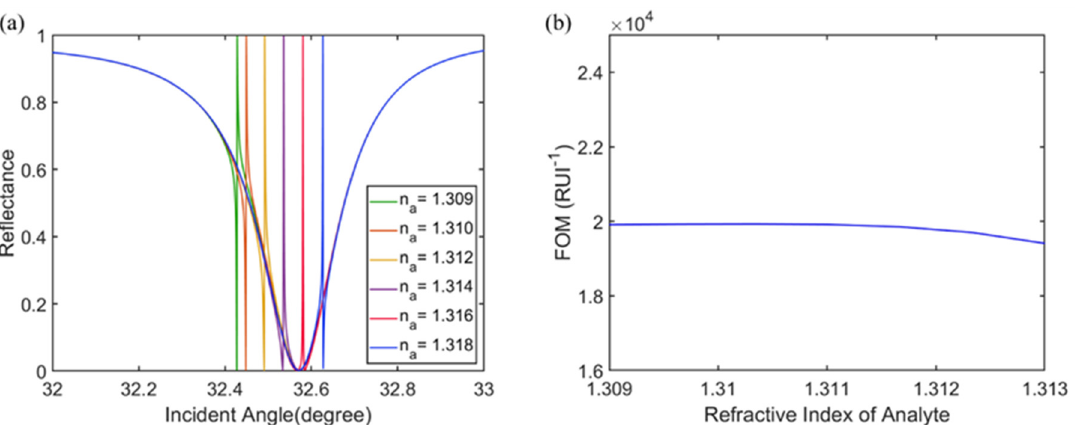
Figure 12. ( a ) The movement of the Fano resonance dip for the different index of the sensing medium and ( b ) variation of FOM with respect to the refractive index of the sensing